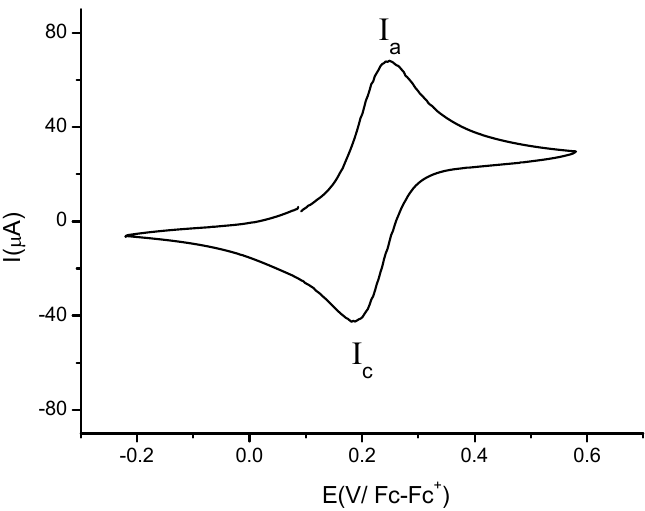
Figure 4. Cyclic voltammogram of compound 3b in the presence of 0.1 M TBABF MeCN. Scan rate 0.1 V·s − 1 . The working electrode used was platinum.